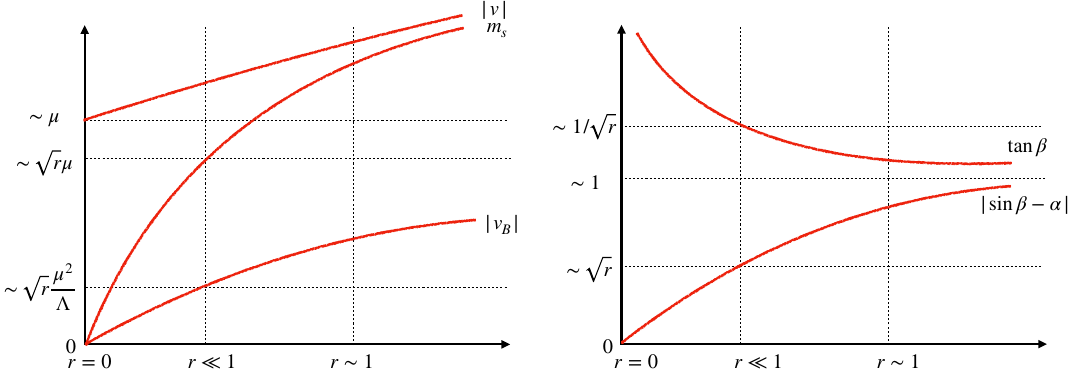
Figure 1 . An illustration of how our physical quantities change in the different r regions. The x-axes start at the point corresponding to r = 0 , and the dashed lines give the rough scale of the parameters at a fixed r . The left panel shows quantities of mass dimension 1 . The right panel shows quantities of mass dimension 0